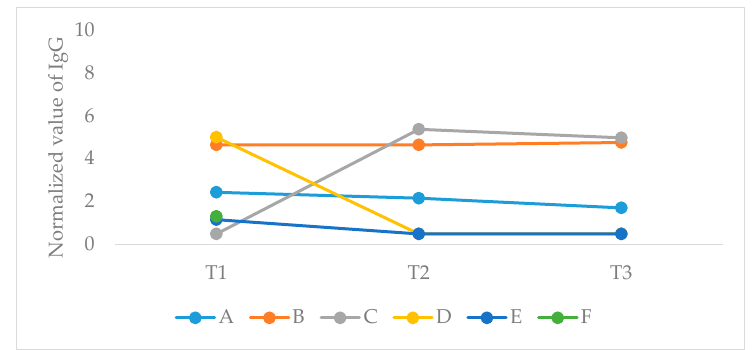
Figure 2. COVID19-positive serology values. Normalized values of SARS-CoV-2 IgG at the three examined time points. Positive expression was considered above the threshold value of 1.4. Participant F had only the T1